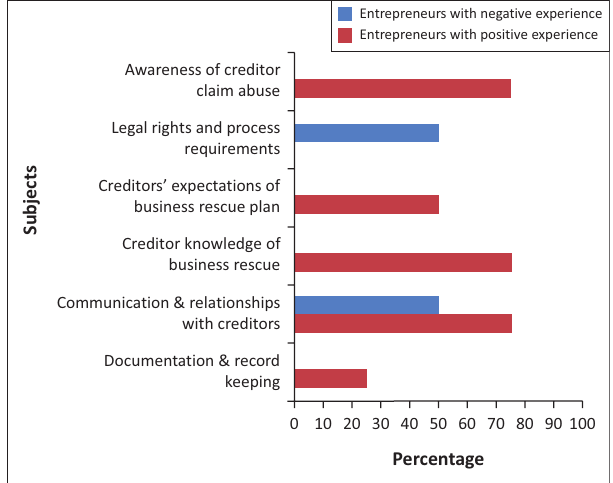
FIGURE 2: Relative indication (percentage reported) of process-related learning content dimensions identified by subjects.